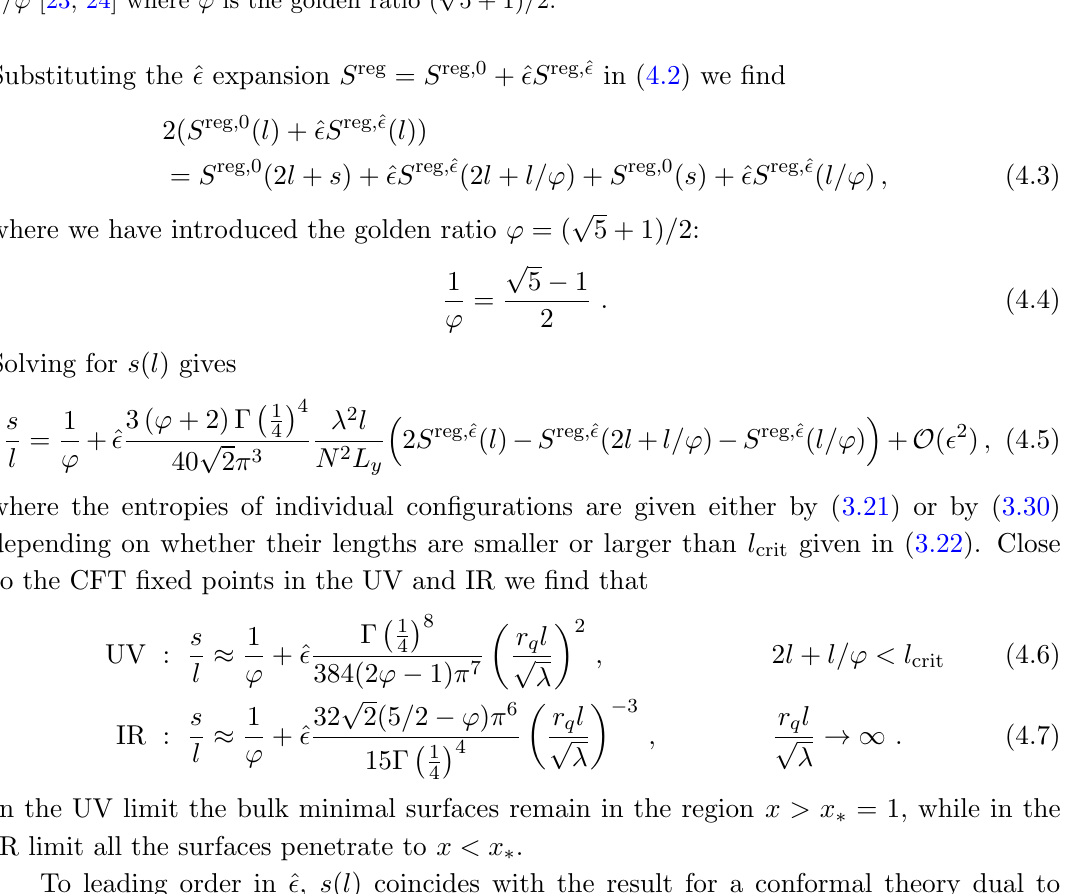
Figure 3 . Bulk extremal surfaces (blue) that can contribute to the holographic mutual information between boundary strips A and B of length l . ( A ) When the separation s of the strips is large the minimal area surface bounded by A [ B is the union of the minimal surfaces for A and B separately. Thus the mutual information (4.1) vanishes because S ( A )+ S ( B ) = S ( A [ B ). ( B ) When the separation s of the strips is small, the minimal area surface bounded by A [ B is the union the pictured surfaces. Thus the mutual information (4.1) is non-vanishing because S ( A ) + S ( B ) > S ( A [ B ). If the theory is conformal (either because there are no quarks, or when they are massless) p the text shows that this mutual information phase transition occurs when s=l j ^ (cid:15) =0 = ( 5 (cid:0) 1) = 2 = p 1 =’ [23, 24] where ’ is the golden ratio ( 5 + 1) =